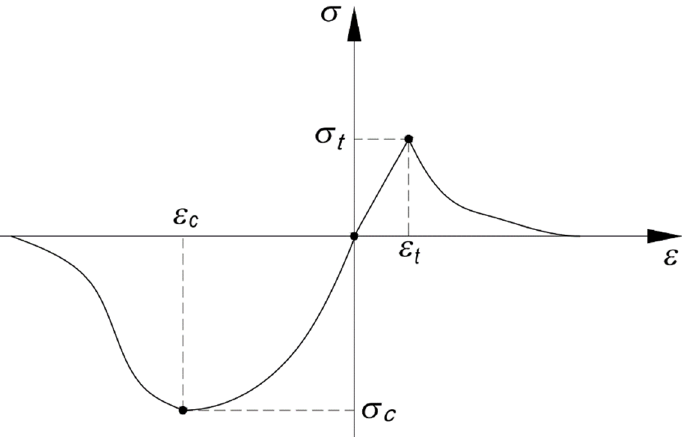
Figure 1. Graph of stress σ -strain ε at uniaxial compression of quasi-brittle material [1].